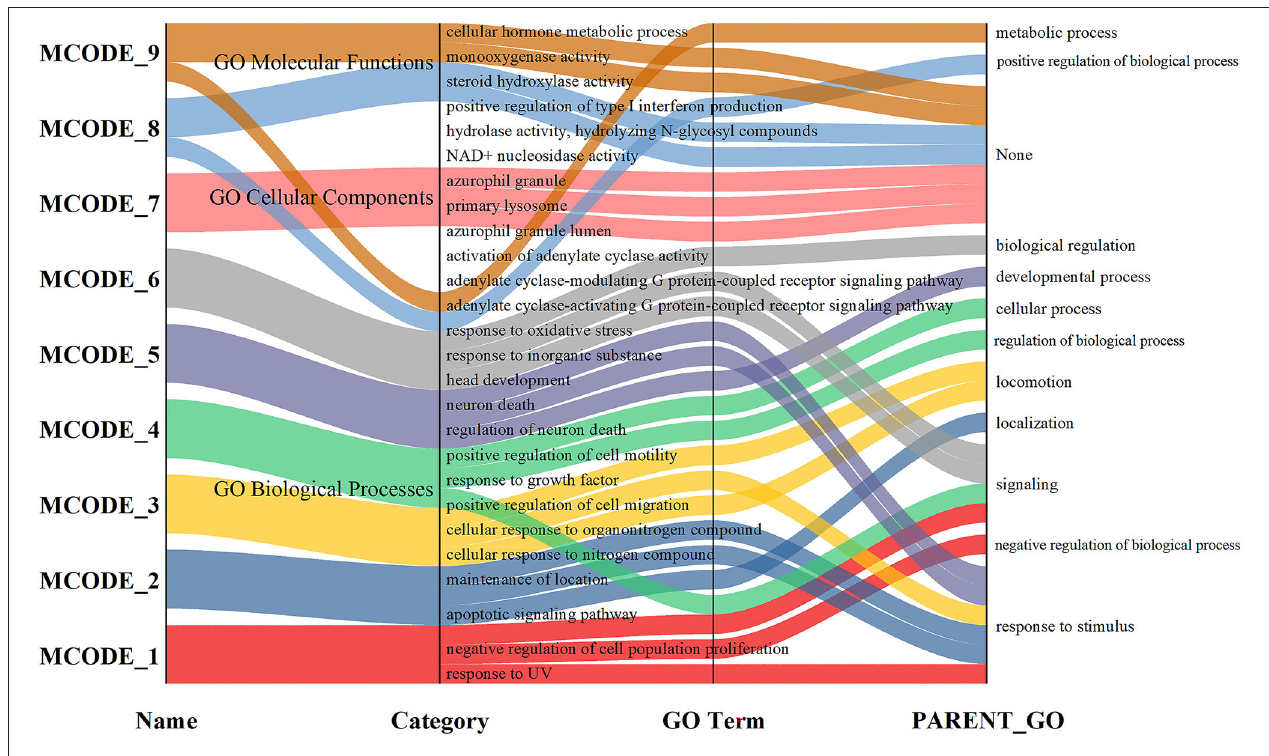
FIGURE 6 | The functional description of the corresponding module.